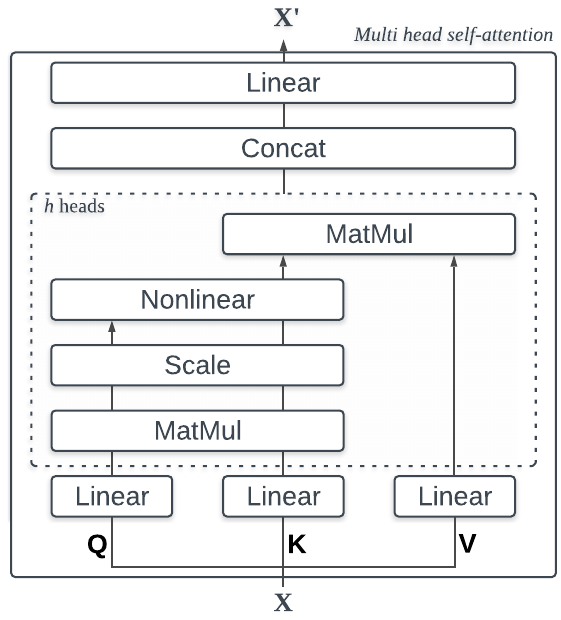
Figure 1. Multi head